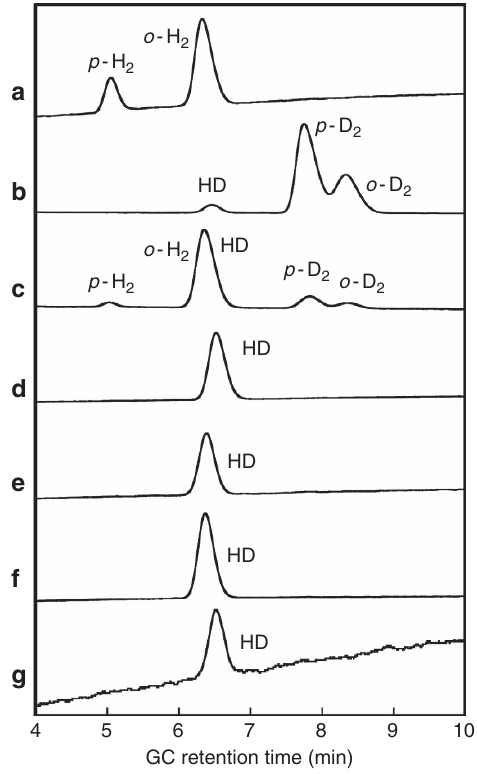
Figure 6 | GC analysis of the gaseous PHER products. GC profiles of ( a ) H 2 , ( b ) D 2 and HD generated by treatment of MeOH- d 4 (99.8%) with sodium metal, and ( c ) HD, H 2 and D 2 generated by the treatment of a mixed MeOH/MeOH- d 4 solution ( v / v ¼ 1/1) with sodium metal; gas samples obtained from MeOH- d 3 (99.5%) solutions of ( d ) apH 2 , ( e ) apH (cid:2) and ( f ) 1 after photoirradiation at 289 ± 10nm (3.2mW, 24h) and ( g ) 1 after photoirradiation at 350 ± 10nm (21.8mW, 24h); GC conditions: 8% KOH alumina column; T ¼